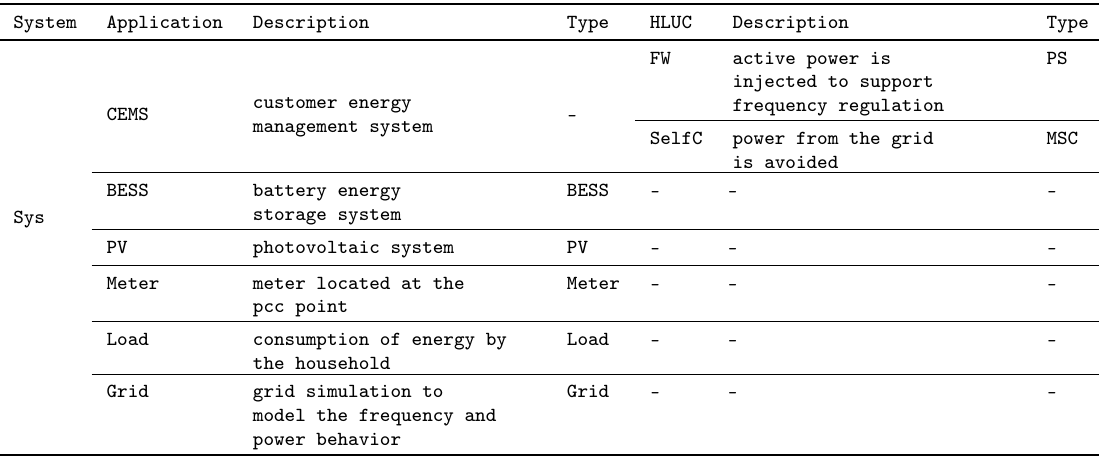
Figure 10. CEMS represented under a SGAM information layer. Table 10. Knowledge of